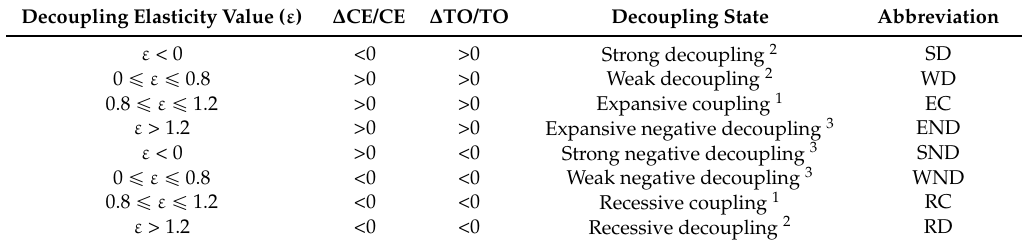
Table A1. Criterion of decoupling elasticity value